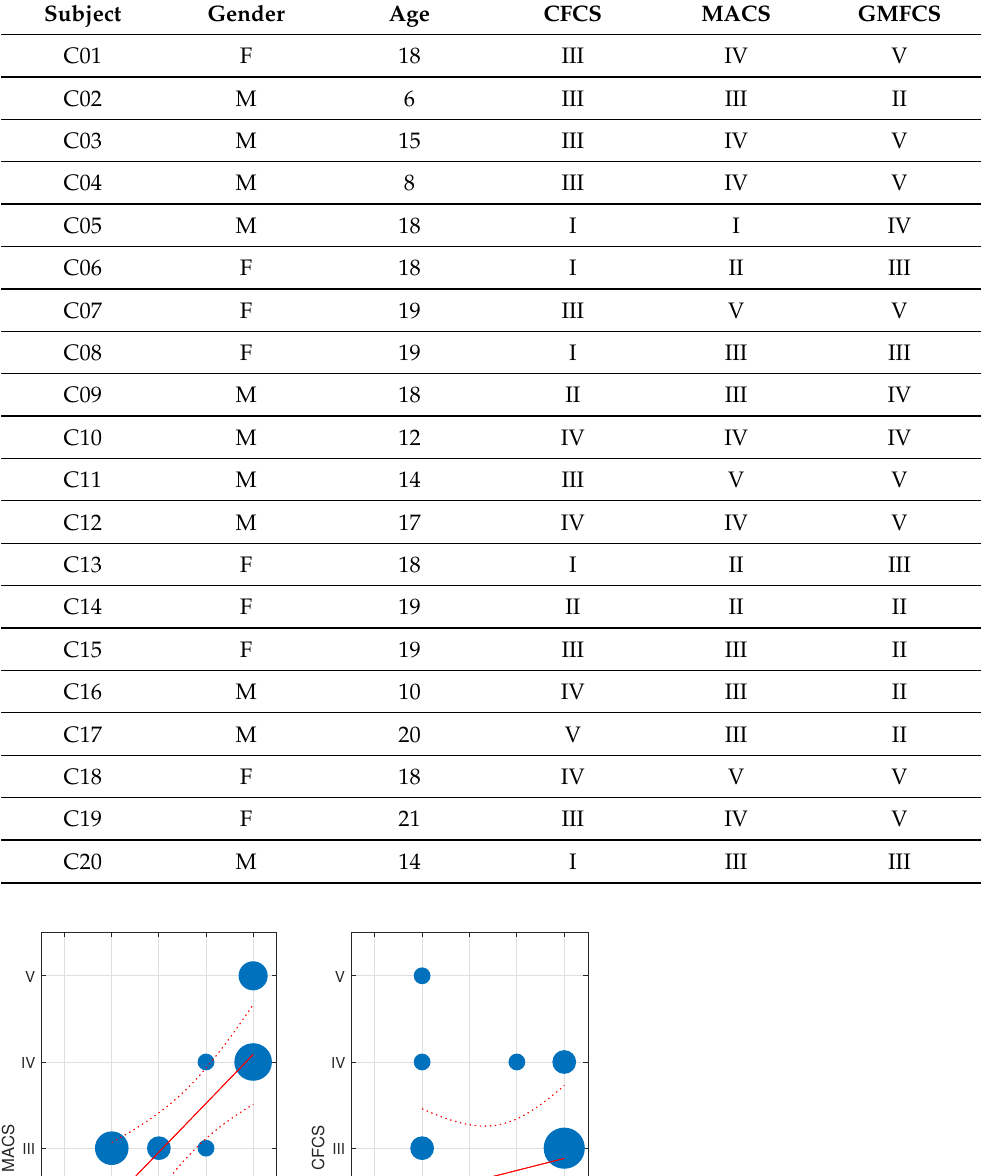
Table 2. Children’s Assessment in Centro Específico de Educación Especial Mercedes Sanromá (CEEEMS), including gender and age.